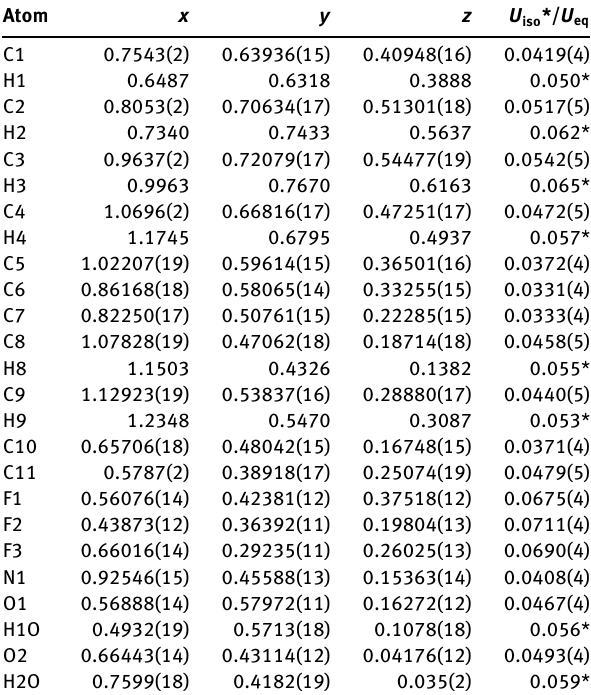
Table 2: Fractional atomic coordinates and isotropic or equivalent isotropic displacement parameters (Å 2